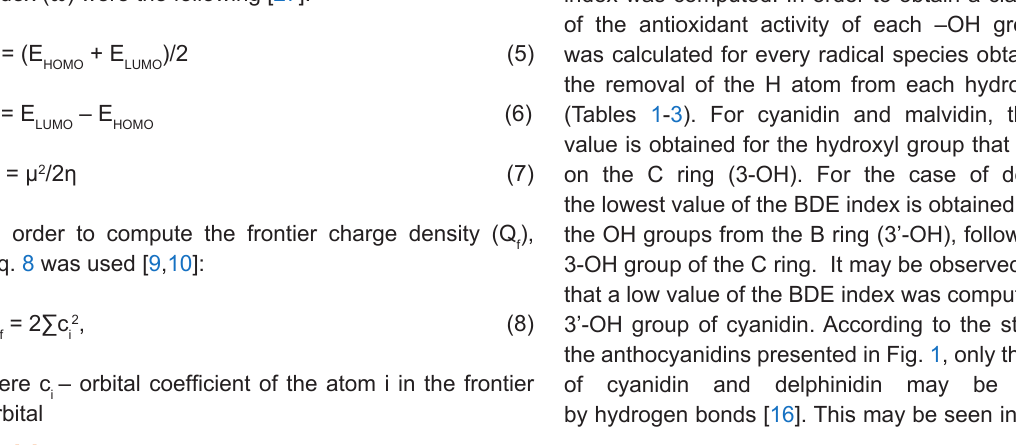
Table 1. Calculated parameters of the three possible radical-scavenging mechanisms for the cyanidin radicals (ROHF/6-31+G(2d,p) level).